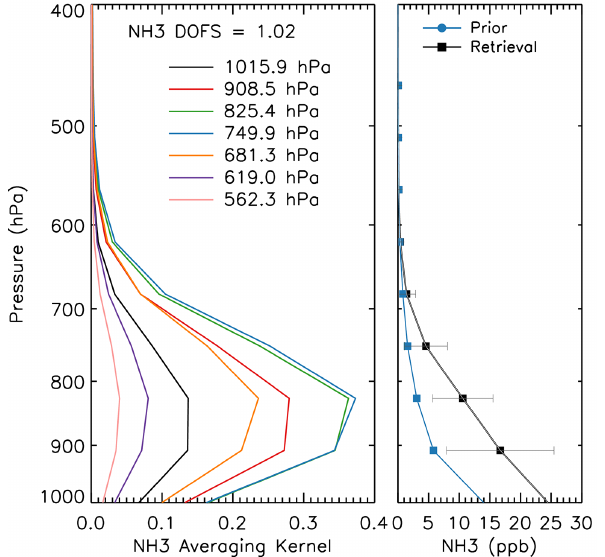
Figure 8. The TES averaging kernel and retrieved profile for the TES pixel that corresponds to the CrIS retrieval plotted in Fig.